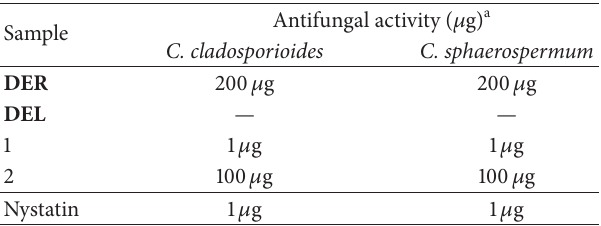
Table 1: Antifungal activity of extracts and compounds from P. dilatatum against Cladosporium cladosporioides and C.